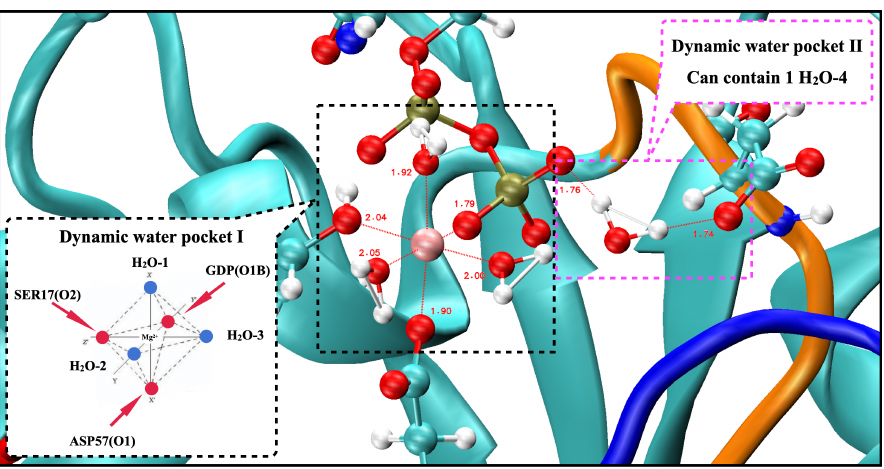
Figure 3. Snapshot of two dynamic pockets on the surface of KRAS-G12D-GDP-Mg 2 + ternary complex.